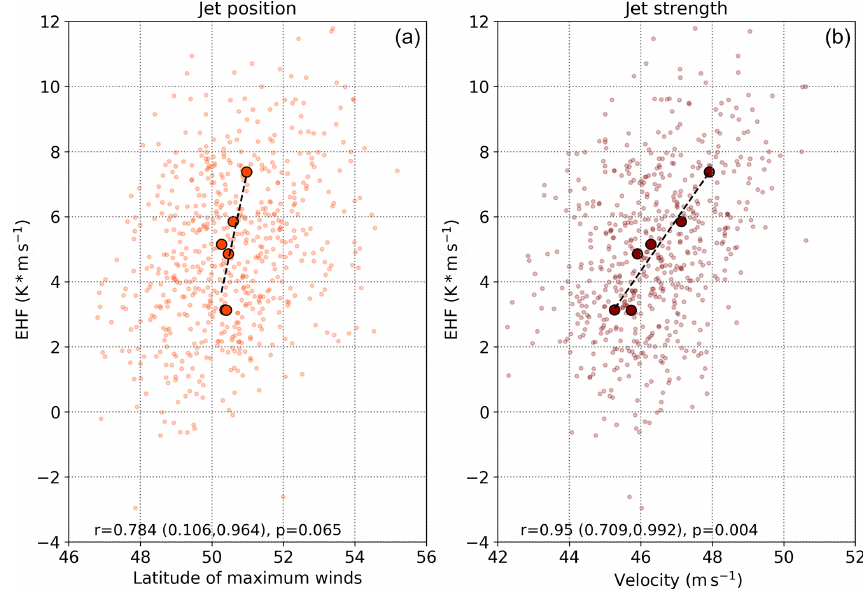
Figure 8. Correlations between summer mean seasonal values of the latitude of maximum 300hPa winds (a) , the magnitude of jet maximum winds (b) , and total eddy heat flux over the North Atlantic (40–80 ◦ N, 290–0 ◦ E). Correlation does not reach 95% significance for jet position, but the correlation with jet strength is robust.